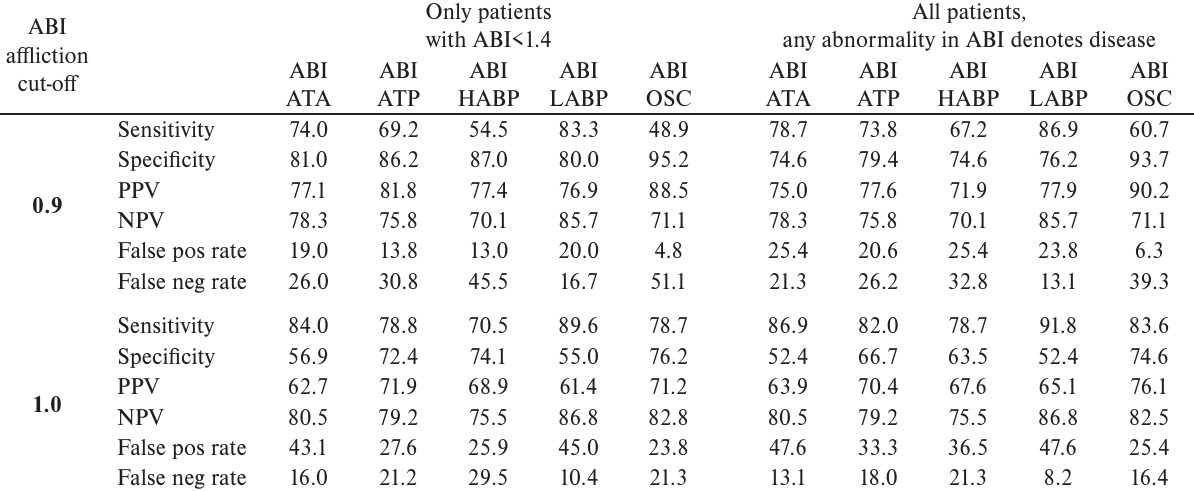
Table 2. Test parameters of different ABI calculations with ABI cut-off values of 0.9 and 1.0.